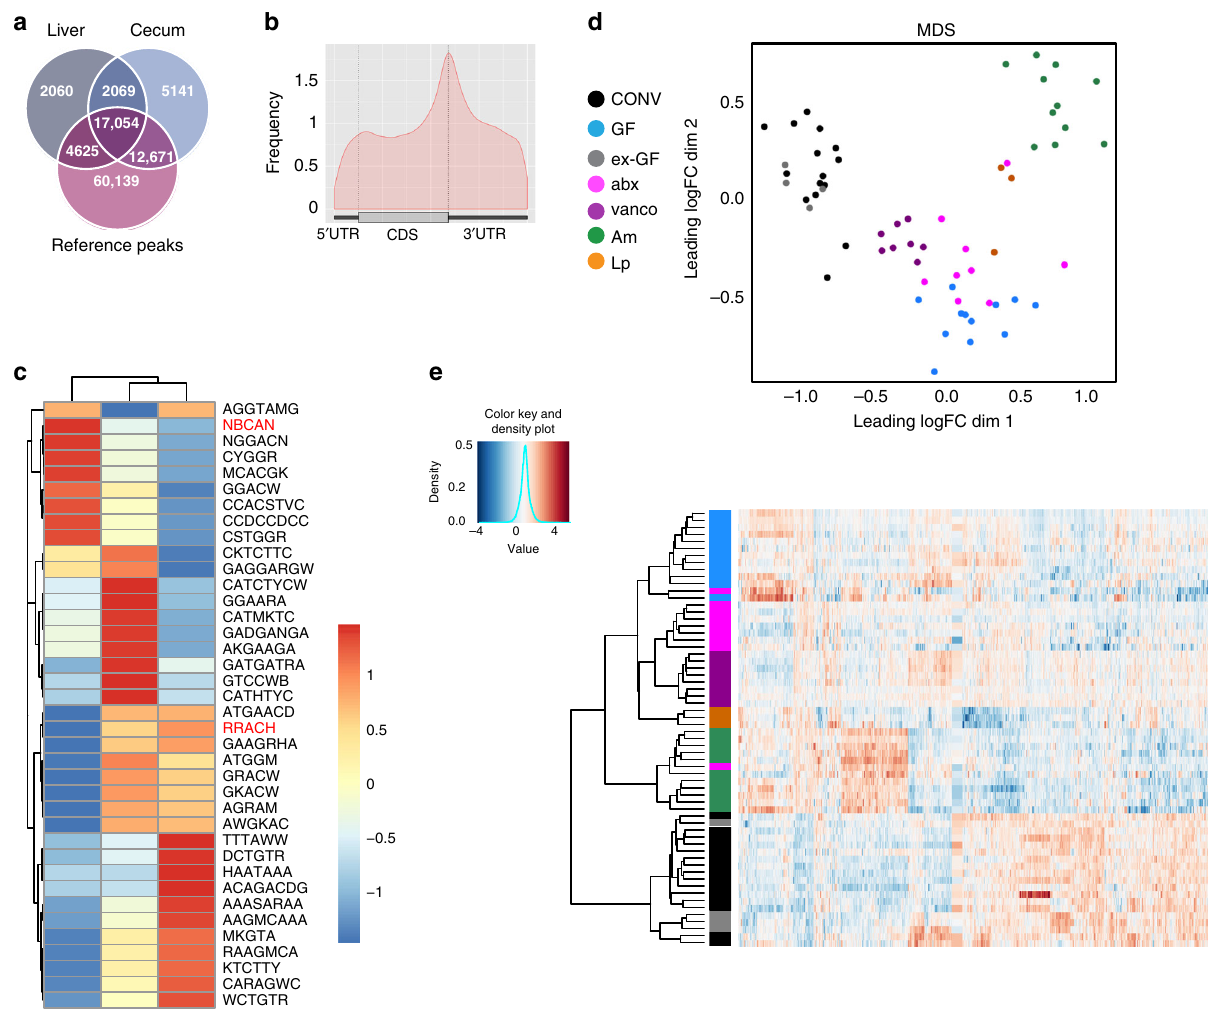
Fig. 1 Microbiota in fl uences m 6 A modi fi cation in mouse cecum. a 67% of m 6 A peaks in the cecum are overlapping with at least one liver peak, and 87% of detected peaks in the cecum are overlapping a MeT-DB v2.0 reference peak. For the liver tissue, 86% of the methylation peaks are overlapping at least one peak of the cecal tissue, and 89% are overlapping a MeT-DB v2.0 reference peaks. The reference peaks may be overlapping with several peaks we detected. b Positions of detected m 6 A peaks on all methylated transcripts in cecum were determined using the GUITAR package. c Motif enrichment in m 6 A modi fi cation was determined by calculating total occurrence of motifs in m 6 A peaks on the 5 ′ UTR, CDS and 3 ′ UTR of transcripts in the cecum. Consensus motifs for m 6 A (RRACH) and m 6 Am (NBCAN) are highlighted in red. d Multi-dimensional scaling (MDS) plot of the peak log2 counts-per- million IP data of all differentially methylated peaks showing the positions of the samples in the space spanned by the fi rst and second MDS dimensions. Samples are colored with respect to condition: CONV ( n = 15), conventionally raised mouse (black); GF ( n = 12), germ-free mouse (cyan); ex-GF ( n = 4), GF mouse colonized with the intestinal content of CONV mice (gray); abx ( n = 9), CONV mice whose gut microbiota has been depleted by antibiotics treatment (magenta); vanco ( n = 8), vancomycin/amphotericinB-treated mice (violet); Am ( n = 11), A.muciniphila -mono-colonized mice (green), Lp ( n = 3), L.plantarum -mono-colonized mice (orange); data were obtained from two independent sequencing experiments using ribodepleted RNA or puri fi ed mRNA from murine cecum. e Heat map of the peak log2 counts-per-million IP data of all differentially methylated peaks. Hierarchical clustering was performed using euclidean distance and ward.D2